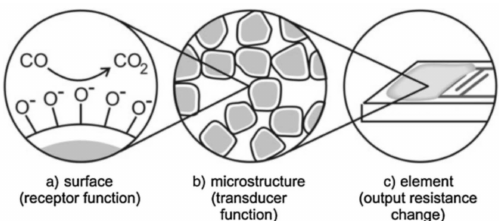
Figure 1. Receptor and transducer functions of a semiconductor gas sensor: ( a ) surface, providing the receptor material function, ( b ) the sensing layer microstructure, providing the transducer function, and ( c ) the element, allowing the detection of the modification in output resistance of the sensing nanolayer, here prepared on an interdigital microelectrode. Reprinted with permission from [30]. Copyright John Wiley and Sons, 2006.